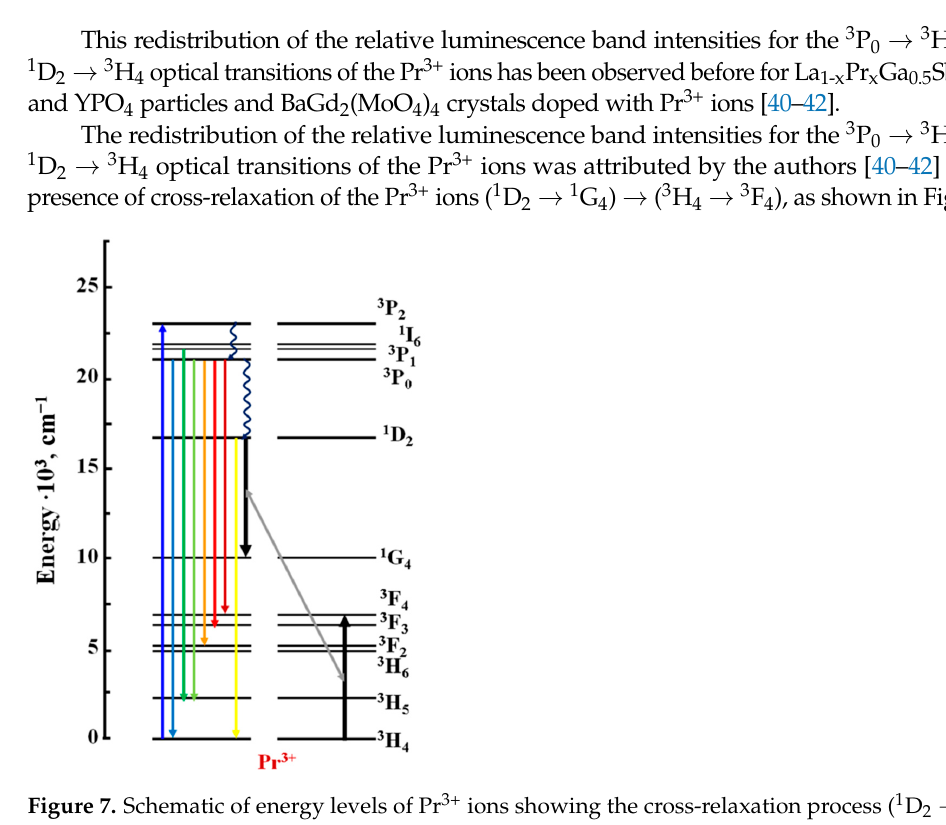
Figure 6. Luminescence spectra of Pr 3+ ions in (ZrO 2 ) 0.802 (Y 2 O 3 ) 0.195 (Pr 2 O 3 ) 0.003 and (ZrO 2 ) 0.805 (Y 2 O 3 ) 0.188 (Pr 2 O 3 ) 0.007 crystals.